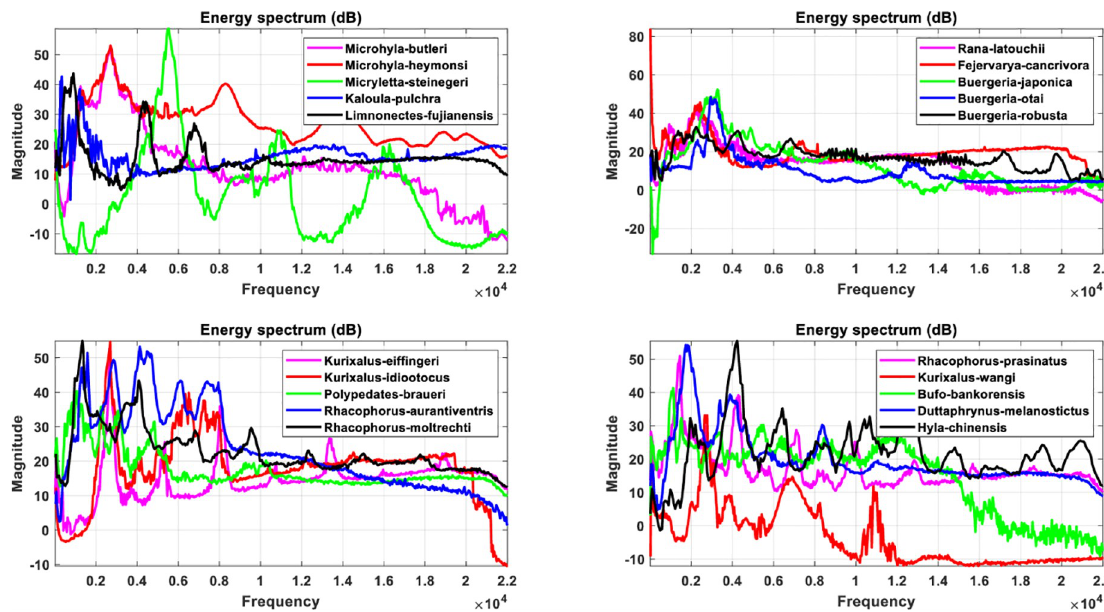
Fig 11. The spectrum diagram of anuran bioacoustic features filtered through the MFCC algorithm with pre-emphasis coefficient equal to 0.9, including Microhyla butleri , Microhyla heymonsi , Micryletta steinegeri , Kaloula pulchra , Limnonectes fujianensis , Rana latouchii , Fejervarya cancrivora , Buergeria japonica , Buergeria otai , Buergeria robusta , Kurixalus eiffingeri , Kurixalus idiootocus , Polypedates braueri , Rhacophorus aurantiventris , Rhacophorus moltrechti , Rhacophorus prasinatus , Khirixalus wangi , Bufo bankorensis , Duttaphrynus melanostictus and Hyla chinensis .